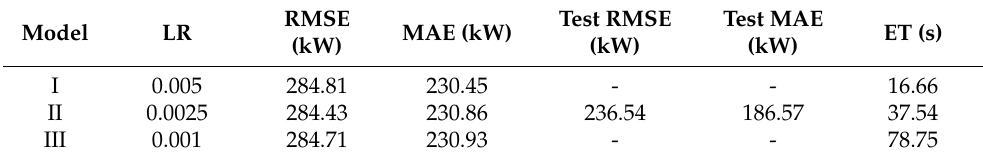
Table 8. Results of the 1-h-ahead error forecasting models.